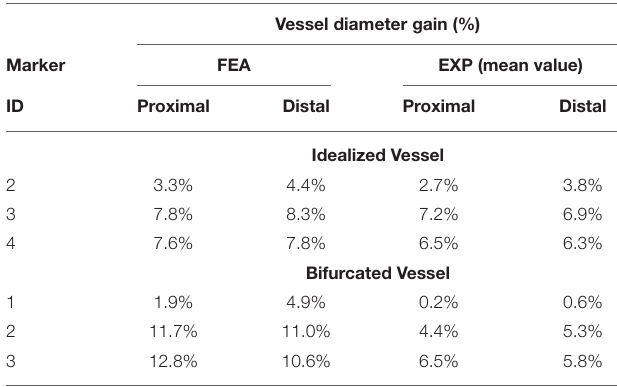
TABLE 4 | Comparison between the diameter gain obtained in the numerical simulations and experiments involving the idealized and bifurcated vessel design. Vessel diameter gain (%) Marker